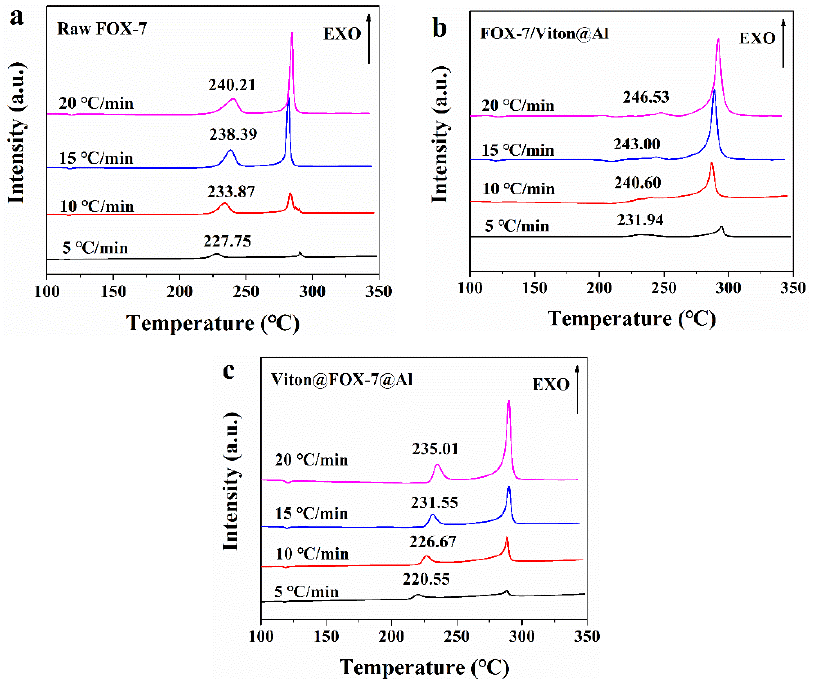
Figure 7. DSC patterns of ( a ) recrystallized FOX-7, ( b ) FOX-7/Viton@Al and ( c ) Viton@FOX-7@Al under the heating rates of 5, 10, 15 and 20 °C·min − 1 . Table 1. Thermal decomposition kinetics of